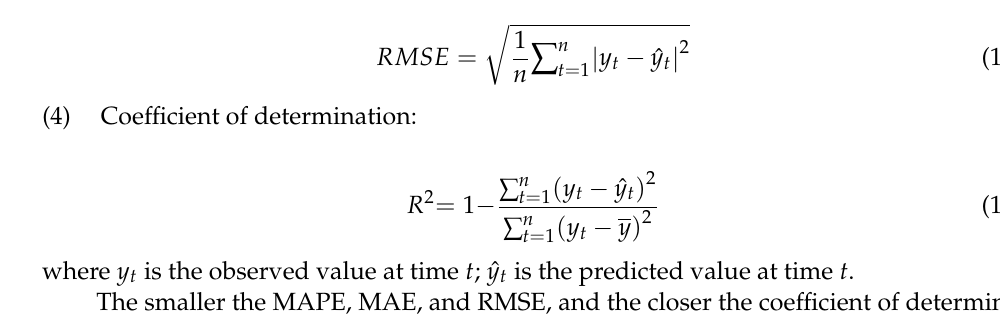
( b ) Figure 5. Comparison of the data before and after processing: ( a ) original data; ( b ) processed data.